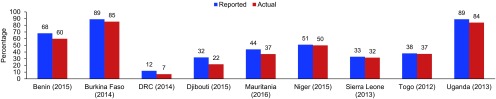
Percentage of Facilities Providing Injectable Contraceptives, Reported Compared With ObservedaAbbreviation: DRC, Democratic Republic of the Congo.a Reported percentage refers to percentage of facilities where a SARA survey respondent reported that a health facility is providing oral contraceptive services. Actual percentage refers to the percentage of facilities where a SARA surveyor observed at least 1 valid stock of oral contraceptives in the service area or in a place where they are routinely stored in the health facility, on the day of the assessment.